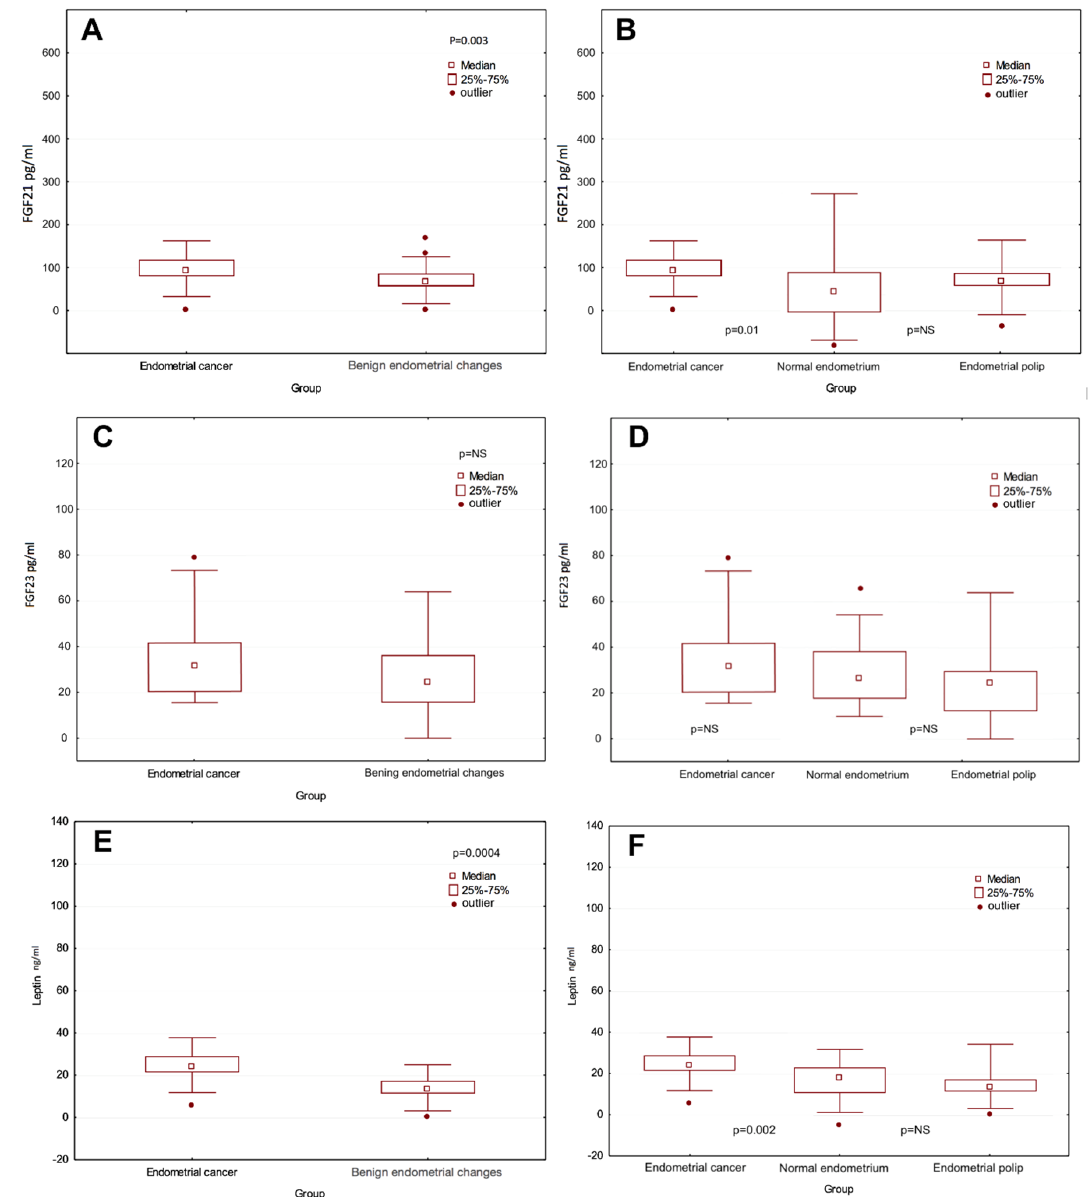
Figure 2. ( A ) FGF21 level distribution in the study and control group. ( B ) FGF21 level distribution in the subgroups. ( C ) FGF23 level distribution in the study and control group. ( D ) FGF23 level distribution in the subgroups. ( E ) Leptin level distribution in the study and control group. ( F ) Leptin level distribution in the subgroups.